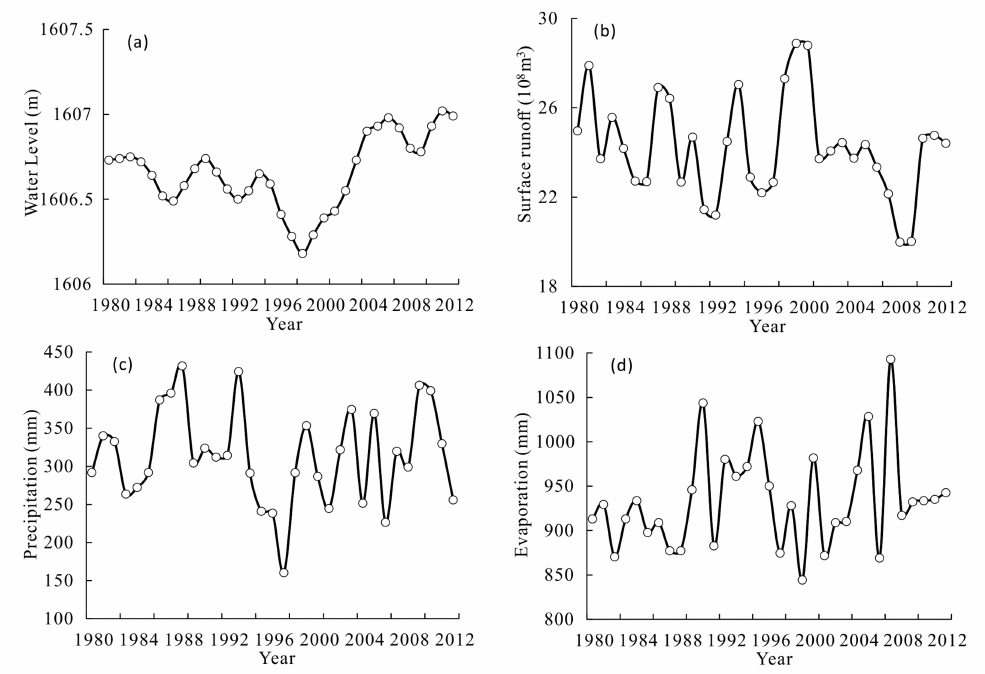
Figure 4. Annual variability of the lake water level, surface runoff, precipitation and evaporation based on the historical data from 1980 to 2012. ( a ) The annual water level of Lake Issyk-Kul; ( b ) Surface runoff averaged across 16 hydrometric stations; ( c ) Annual precipitation averaged across four meteorological stations; ( d ) Annual evaporation at the Karakol